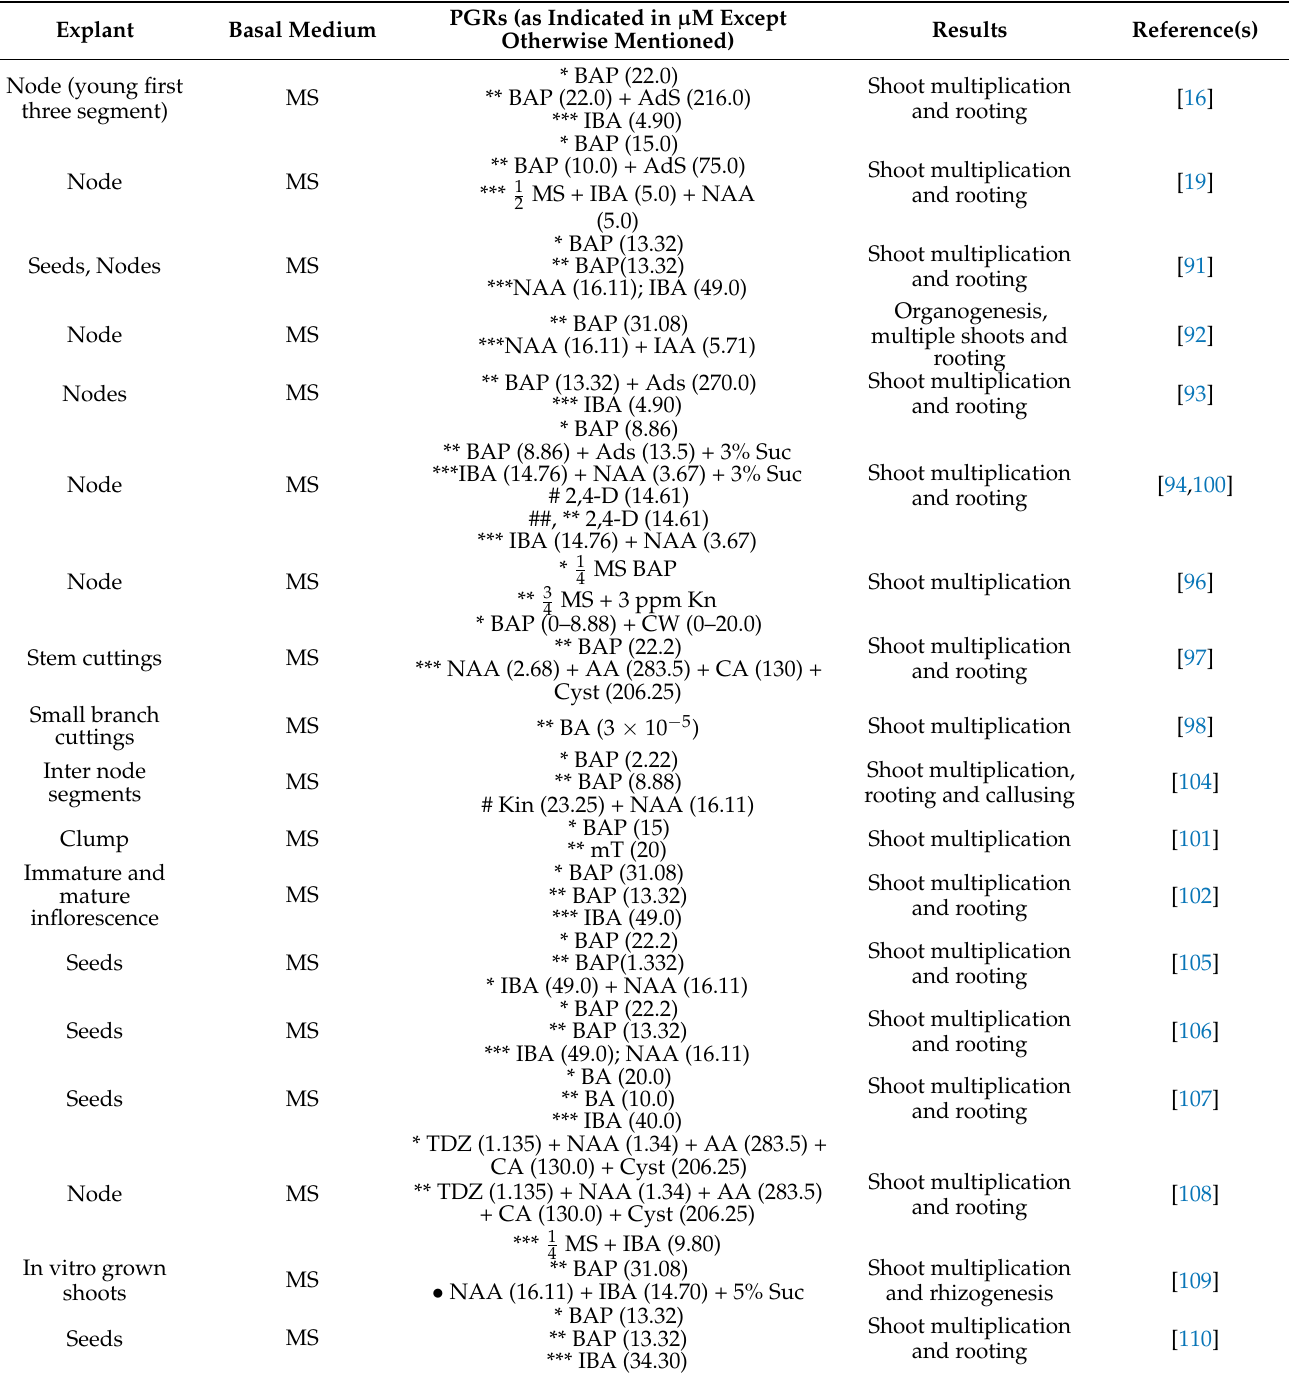
Table 1. Successful micropropagation of D. asper via organogenesis from various explants.